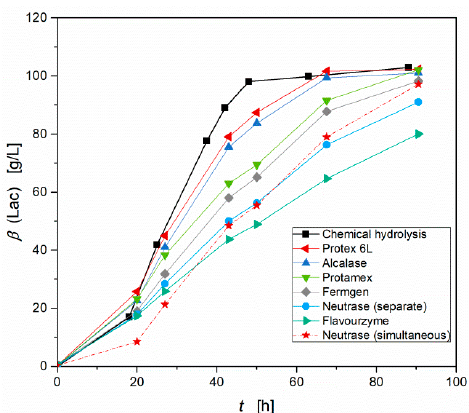
Figure 5. Effect of different proteases for enzymatic hydrolysis of rapeseed meal on lactic acid production by S. inulinus compared to the chemical hydrolysis, incubated at 38 °C, 0 rpm.